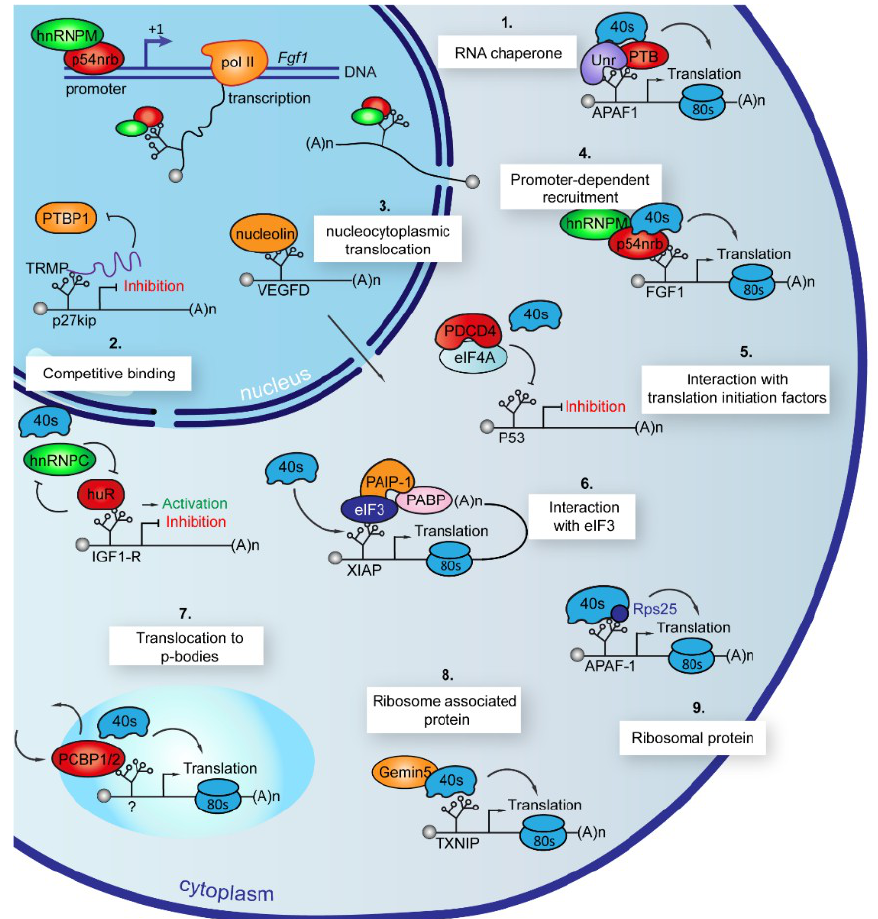
Figure 2. The ITAFs use different mechanisms of action to control IRES-dependent translation. The different reported mechanisms of ITAFs to regulate IRES activities are schematized. For each mechanism, an example is shown with the names of the ITAF and of the IRES. The start point of translation is indicated by an arrow if translation initiation is increased or by a blocked arrow if translation initiation is inhibited. Each mechanism is detailed in the text.